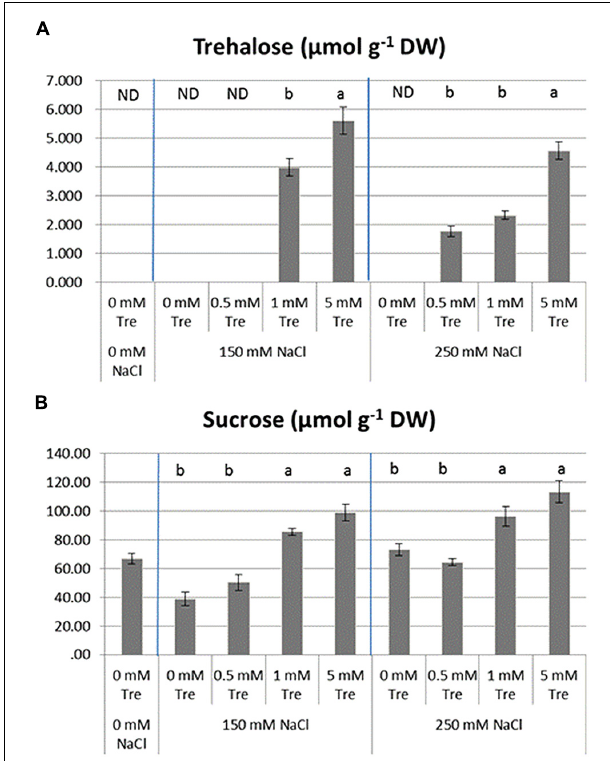
FIGURE 7 |The effects of exogenous trehalose on leaf soluble sugar levels in the control or salt-stressed plants. (A) Trehalose. (B) Sucrose. The results showed are the mean ± SE of three replicates and the different letters denote the significant difference among different treatments ( P < 0.05). ND, no detection;Tre,